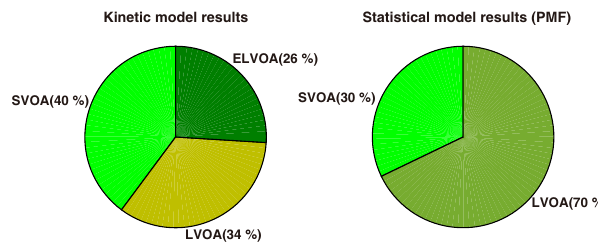
Figure 6. Median organic volatility distribution of the ambient aerosols of this study obtained from the VTDMA data interpreted by the kinetic evaporation model (Riipinen et al., 2010) and the AMS data derived from the PMF analysis. (cid:49)H Vap = 80kJmol − 1 was used in the kinetic evaporation